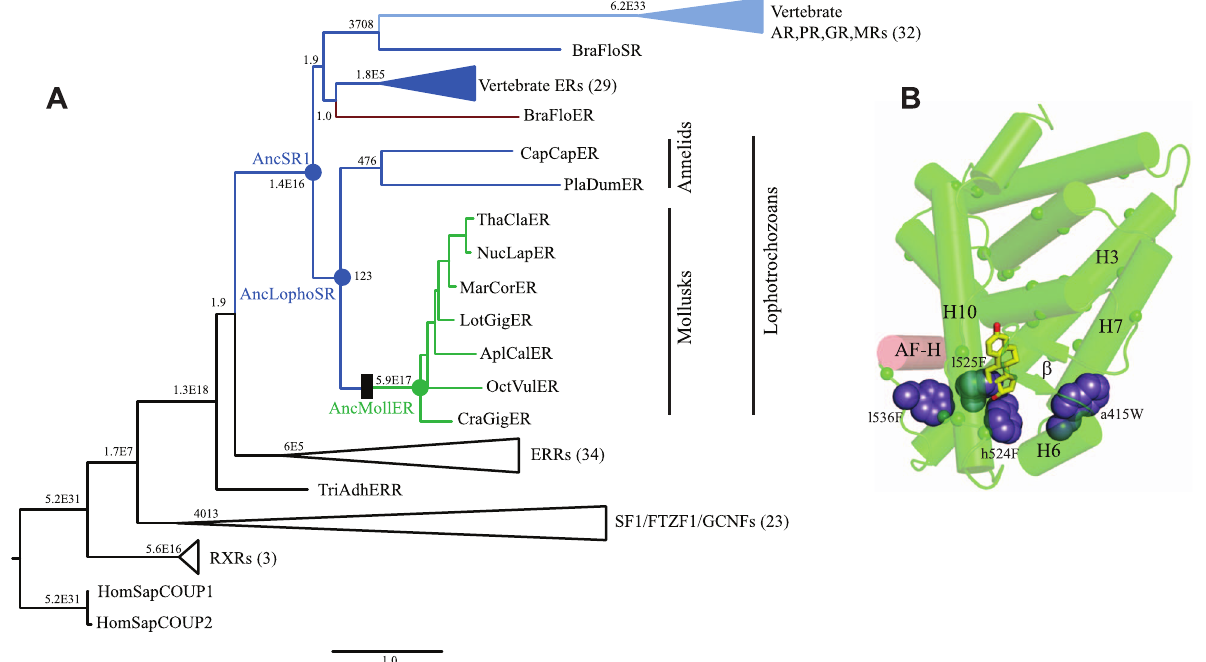
Figure 3. Constitutive activity evolved on the branch between ancestral lophotrochozoan and mollusk steroid receptors. A. Phylogeny of steroid receptors and related proteins. The maximum likelihood phylogeny of 135 protein sequences is shown; clades containing multiple closely related proteins are shown as wedges with the number of sequences in parentheses. Branch labels show statistical support for each node as the approximate likelihood ratio in scientific notation. Members of the SR clade are colored by mode of allosteric regulation: receptors activated by estrogen or other steroids are colored dark or light blue, respectively; constitutively active transcription factors are green; proteins that act as dominant negative regulators of transcription are red. Scale bar, substitutions per site. Black box represents evolutionary gain of constitutive transcriptional activation and loss of ligand binding. Ancestral proteins referred to in the text are labeled as AncSR1 (ancestral steroid receptor), AncLophoSR (SR in the ancestor of lophotrochozoan species), and AncMollER (ER in the ancestor of mollusks). Exant species abbreviations are: AplCal, Aplysia californica , BraFlo, Branchiostoma floridae , CapCap, Capitella capitata , CraGig, Crassostreas gigas , HomSap, Homo sapiens , LotGig, Lottia gigantia , MarCor, Marisa cornuarietis , NucLap, Nucella lapillas , OctVul, Octopus vulgaris , PlaDum, Platynereis dumerilii , ThaCla, Thais clavigera , TriAdh, Trichoplax adhaerens . B. Candidate causal substitutions for the shift in allosteric regulation in the mollusk steroid receptors. Residues that changed between AncLophoSR and AncMollER and are conserved in all or all but one extant mollusk ER are indicated by small spheres for C a carbons. Of these, four (shown as large blue spheres) occupy positions close to the ligand cavity of other SRs. AF-H is red; estradiol, as positioned in the human ER a structure (1GWR), is shown as yellow sticks.